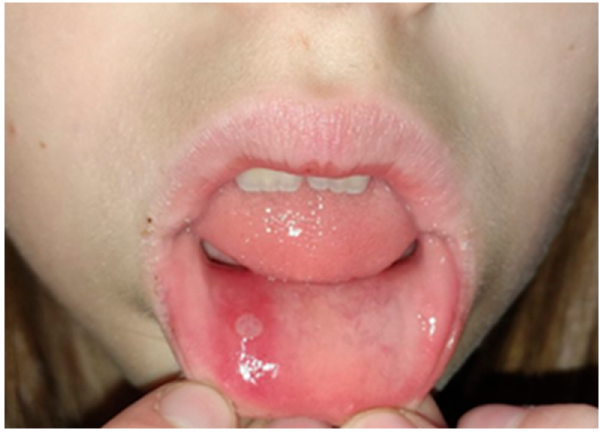
Figure 2. Aphtae